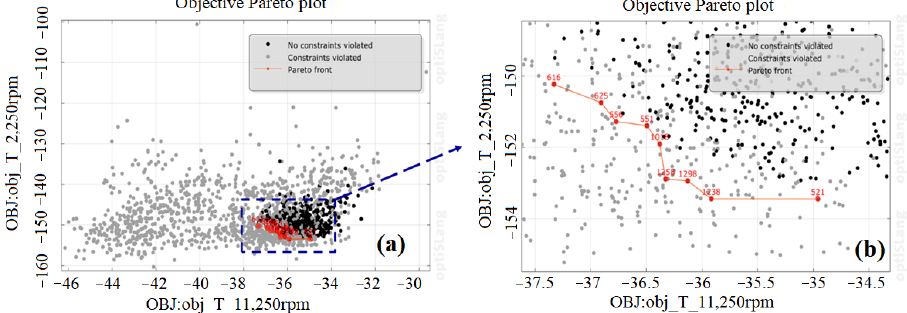
Figure 6. Optimization analysis results of ( a ) objective Pareto plot and ( b ) the front of the optimal solution. Table 6. Input parameters before and after optimization.